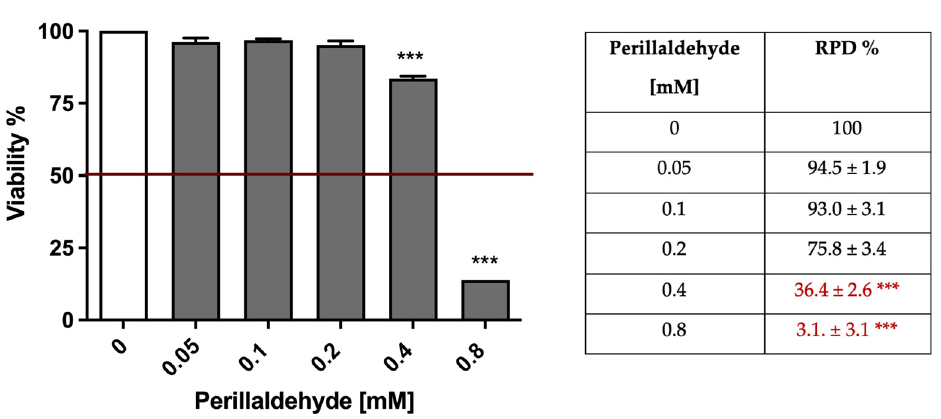
Figure 3. Cell viability ( left ) and RPD ( right ) on TK6 cells after 3 h treatment with perillaldehyde followed by 23 h of recovery in the complete medium at the indicated concentrations compared to the untreated cultures (0). In red are indicated the RPD values not in compliance with the OECD recommended threshold. *** p < 0.001 vs.